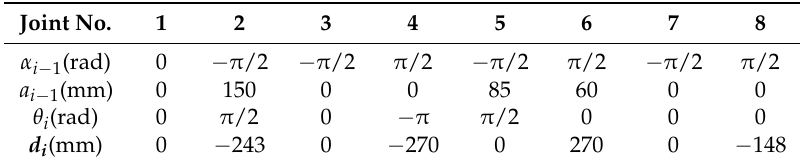
Table 2. DH parameters of